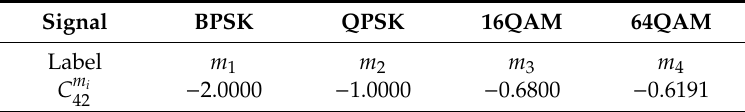
Table 1. The theoretic normalized fourth-order cumulant for some phase shift keying (PSK) and quadrature amplitude modulation (QAM) signals